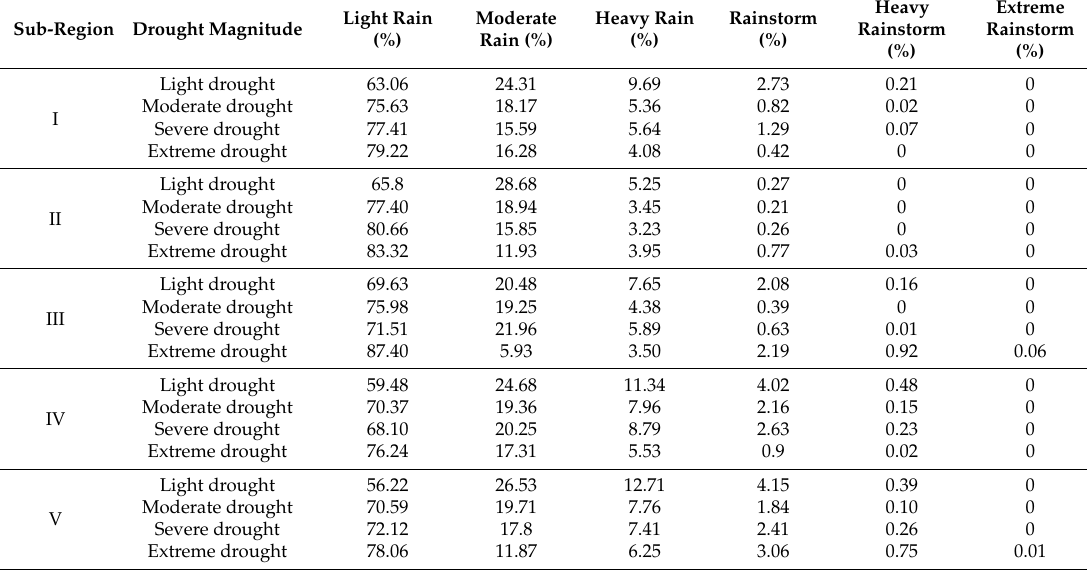
Table 4. Precipitation intensity changes after droughts of different magnitude for each sub-region. Sub-Region Drought Magnitude